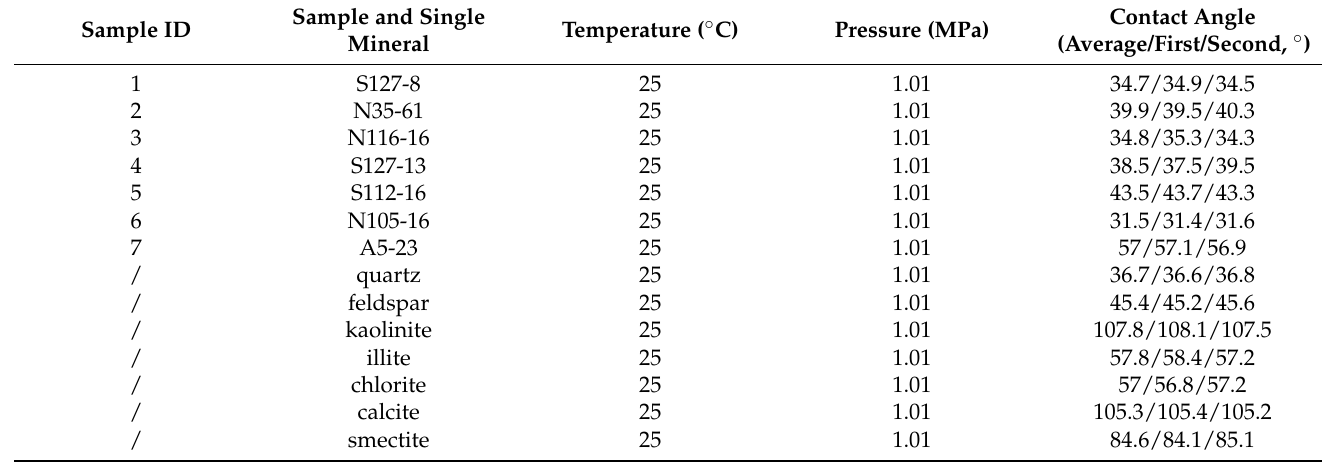
Table 5. Measurement results of contact angle of samples and single minerals.